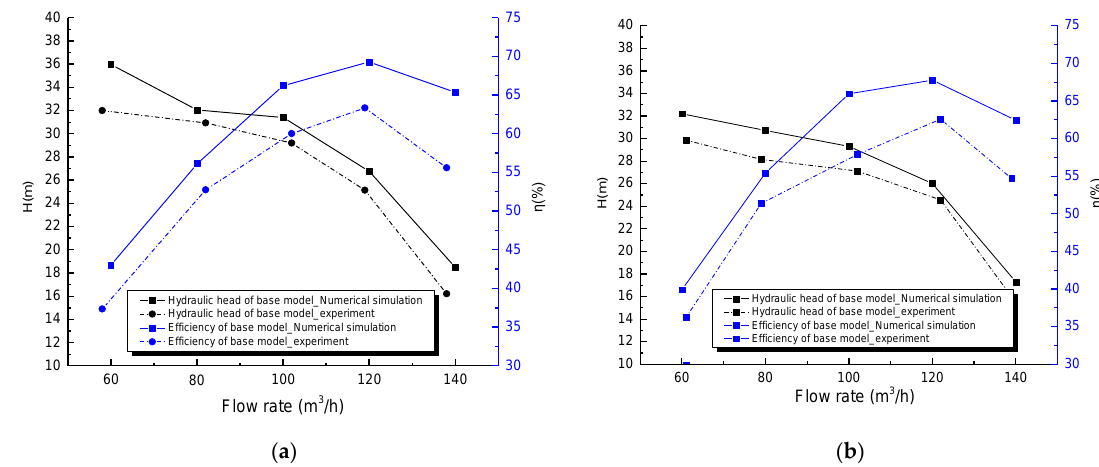
Figure 4. Hydraulic performance curves of a multiphase pump with different flow rates. ( a ) Inlet gas volume fraction (IGVF) = 30% and ( b ) IGVF = 50%.